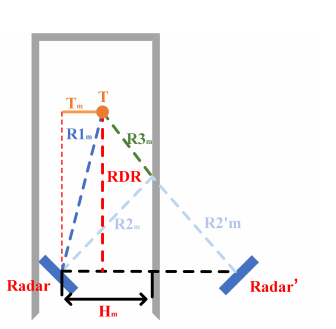
Figure 9. Obtaining the target horizontal axis distance.